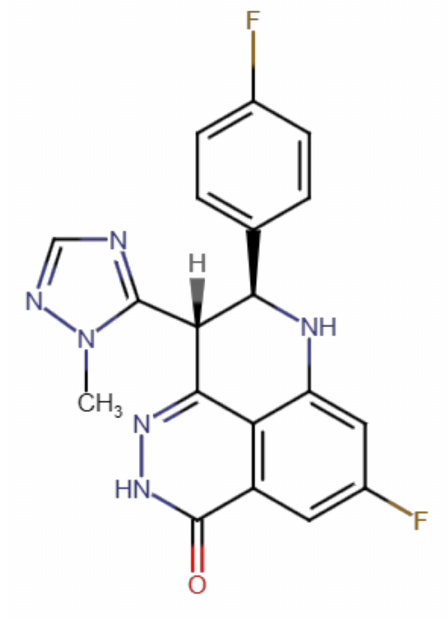
Figure 1. The structure of